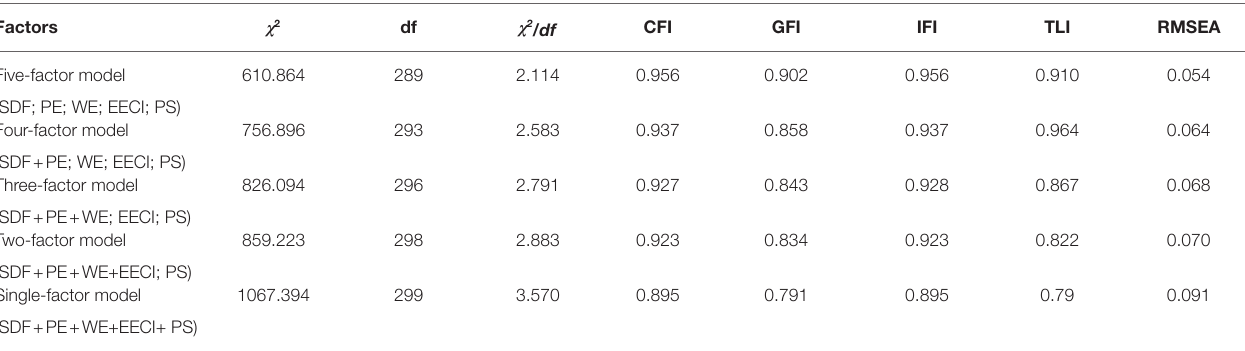
TABLE 3 | The result of confirmatory factor analysis ( N =